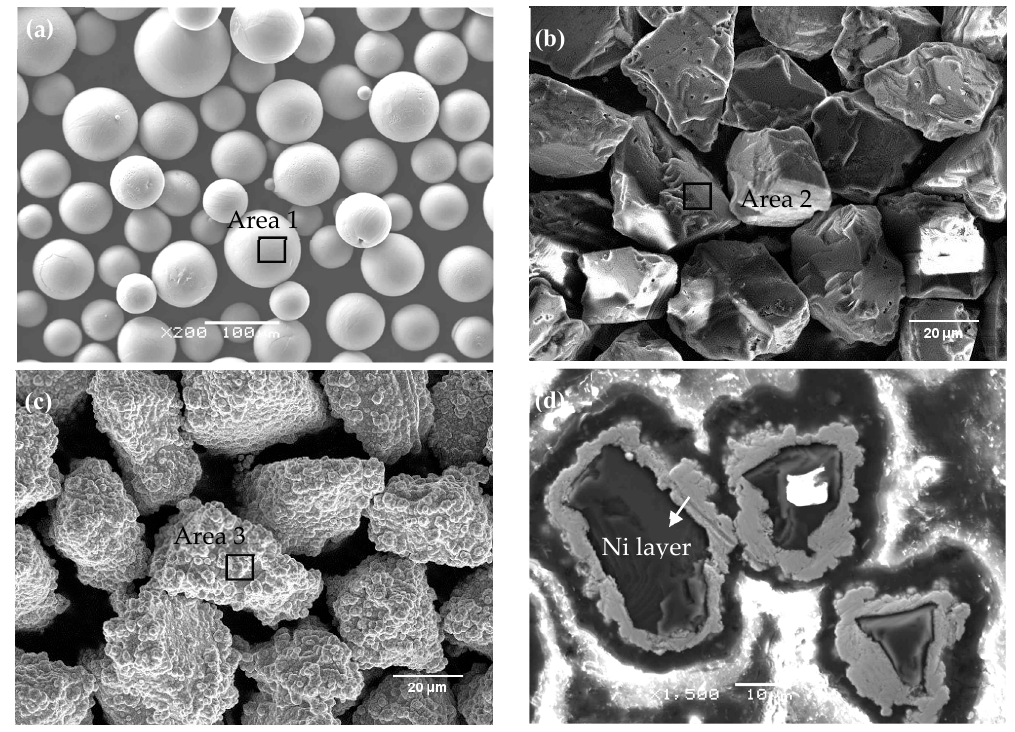
Figure 1. Morphologies of the Ti6Al4V, cubic boron nitride (cBN) powder and nickel-plated cBN powder (NicBN): ( a ) Ti6Al4V particles; ( b ) cBN particles; ( c ) NicBN particles; and ( d ) Ni coating. Table 1. The elemental concentration of the selected areas in Figure 1.